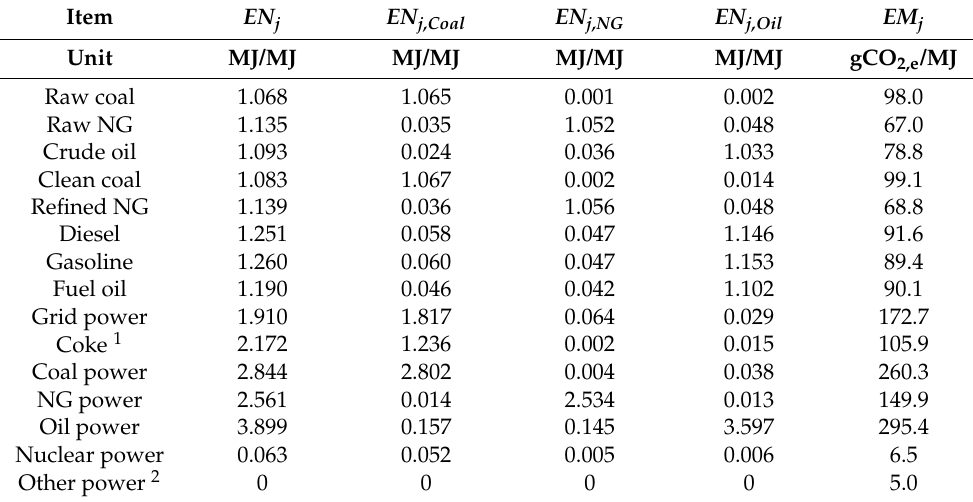
Table 4. LC PE and GHG emissions intensity of each